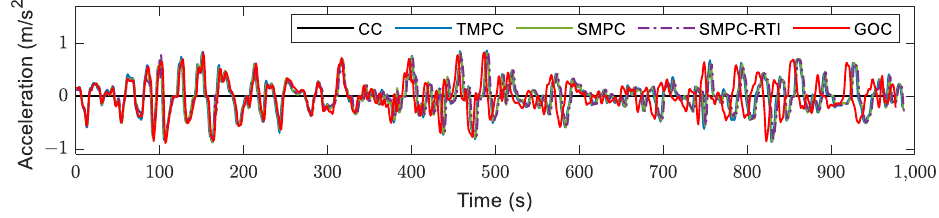
Figure 11. Acceleration of different speed controllers on the expressway.